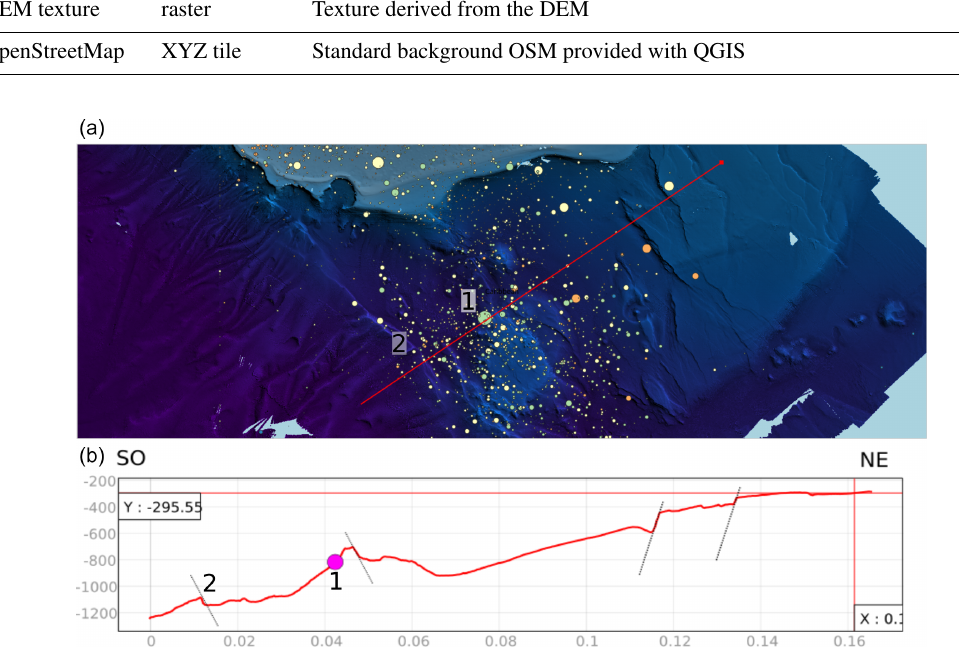
Figure 1. Snapshot of the QGIS desktop showing an example of interpretation by a student of a bathymetric profile (b) crossing the normal fault system perpendicularly (red line in a ) using the terrain profile tool. The student has represented supposed normal fault planes with a dashed line and the mainshock epicenter with a purple dot (1). The Roseau fault is indicated in both the map and profile view